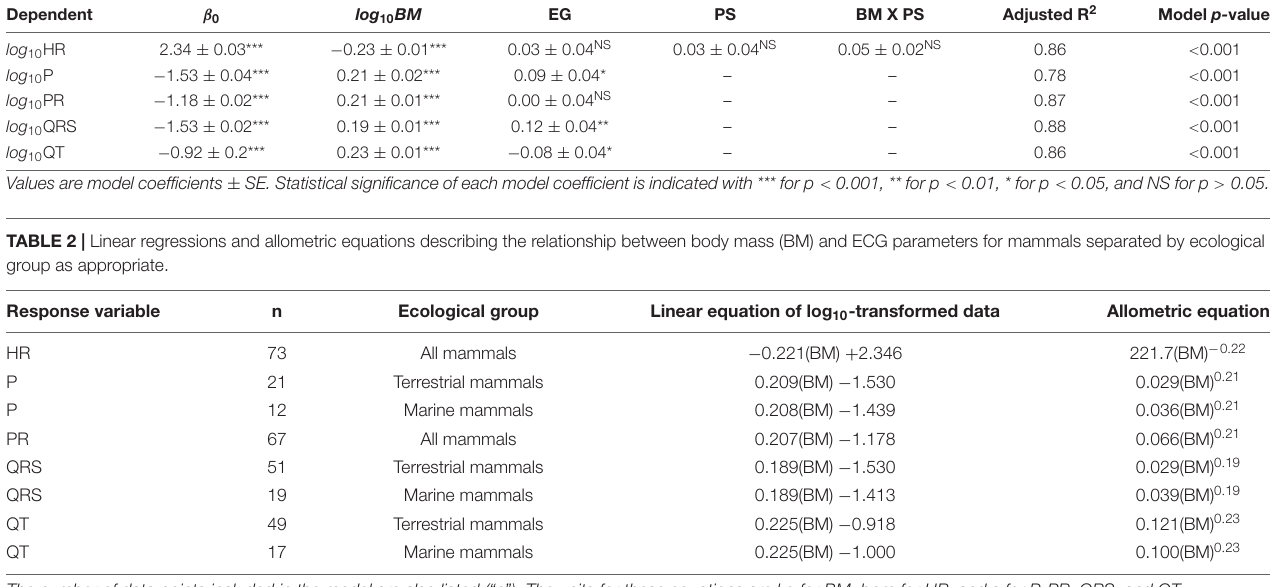
TABLE 1 | Multiple linear regression model parameters for relationships between body mass (BM), ecological group (EG), physiological state (PS), and ECG parameters. In these models, the factor EG is 1 for a marine mammal and 0 for a terrestrial mammal and the factor PS is 1 for anesthetized individuals and 0 for conscious individuals. Dependent